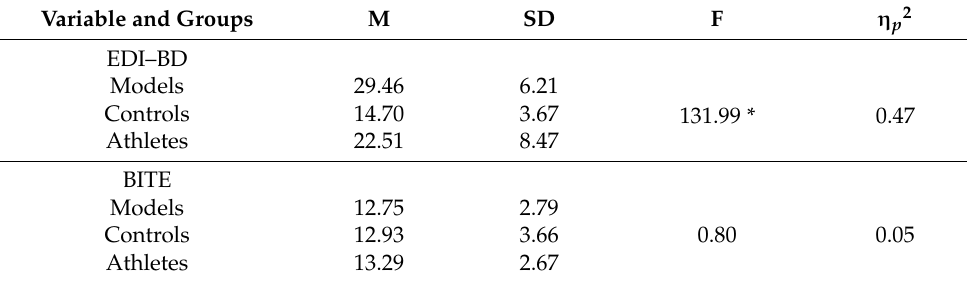
Table 2. Analysis of Variance (ANOVA)